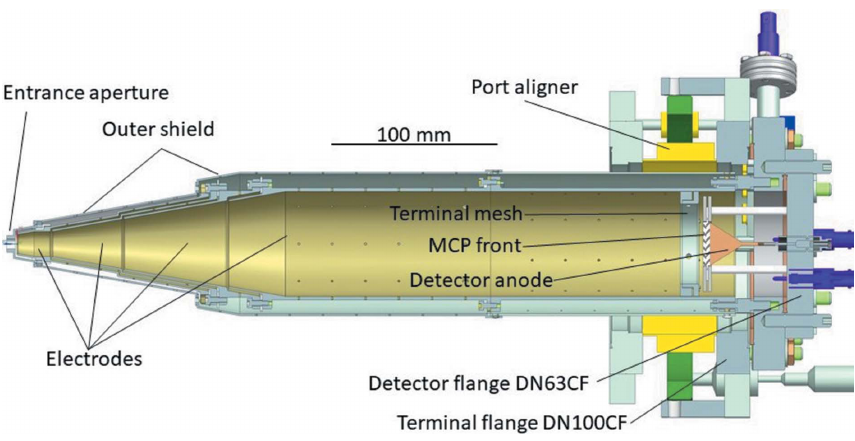
Figure 1 CAD-cutout of the spectrometer. From left to right are the aperture, the electrodes of the conical lens and the drift tube, the mesh, the detector and its conical anode, the flanges with alignment mechanism, and electric